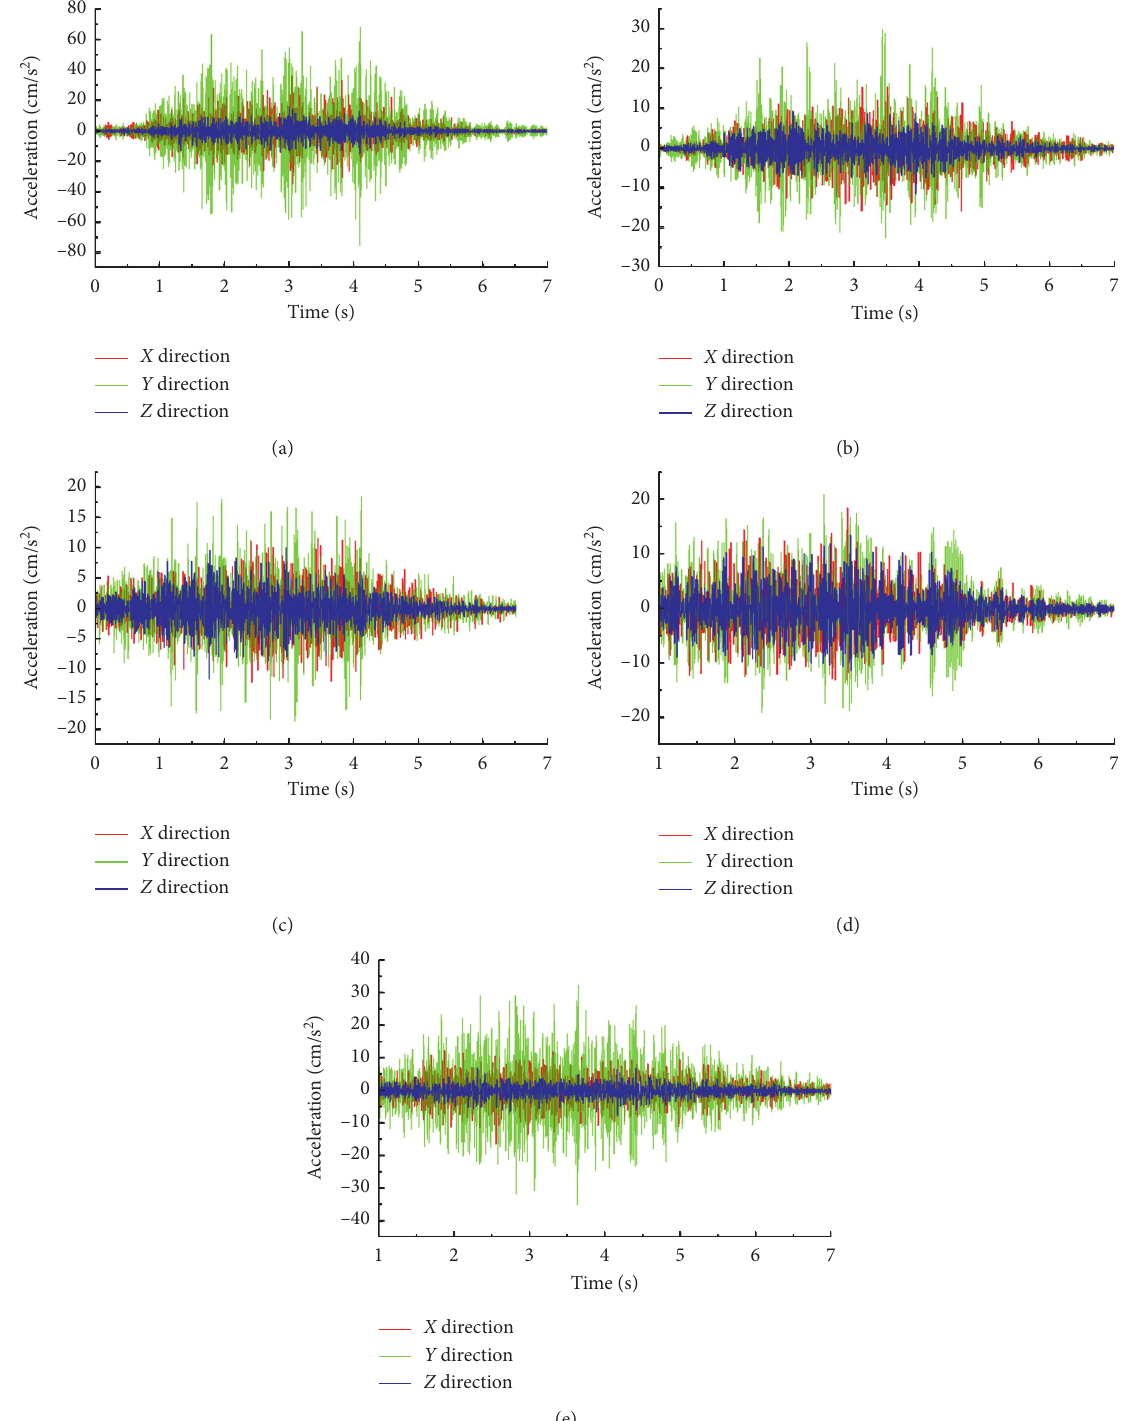
Figure 5: Acceleration time history curve of different test points when train no. 2 passed. (a) No. 1. (b) No. 2. (c) No. 3. (d) No. 4. (e) No.